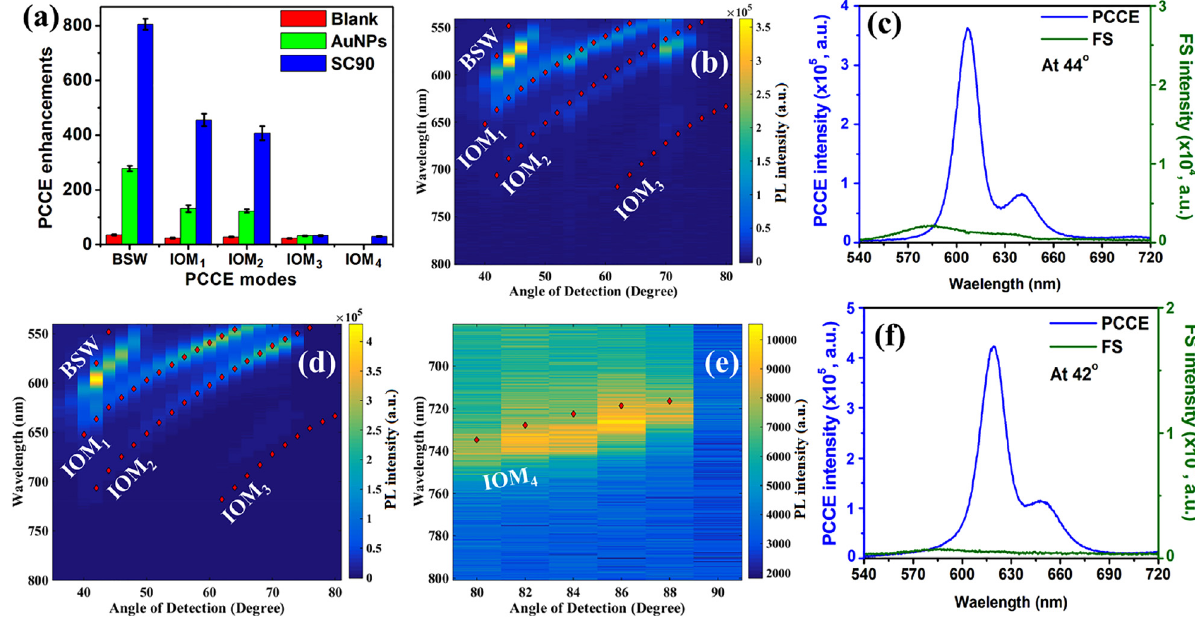
Figure 4: (a) PCCE enhancements for different modes (BSWs, IOM 1 , IOM 2 , IOM 3 and IOM 4 ) for blank, AuNPs, SC90 samples. (b) Dispersion diagram presenting overlap of numerical (dotted line for 60 nm PVA) and experimental data for use of 60 nm PVA doped with AuNPs in PCCE platform. (c) PCCE pro fi le along with corresponding FS pro fi le for BSW-coupled emission of (b) that presented maximum emission